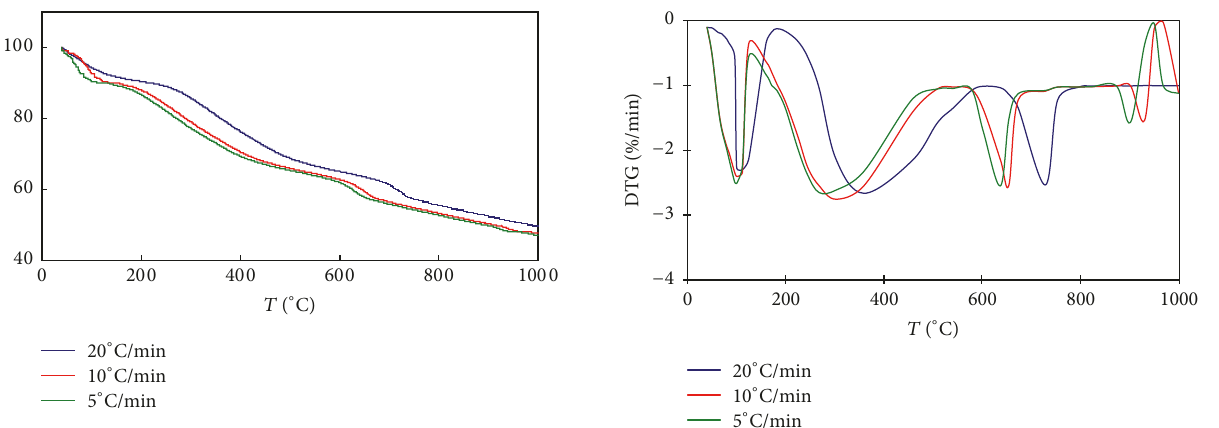
Figure 1: The TG curves for pyrolysis of sediment at different heating rates. Figure 2: The DTG curves for pyrolysis of sediment at different heating